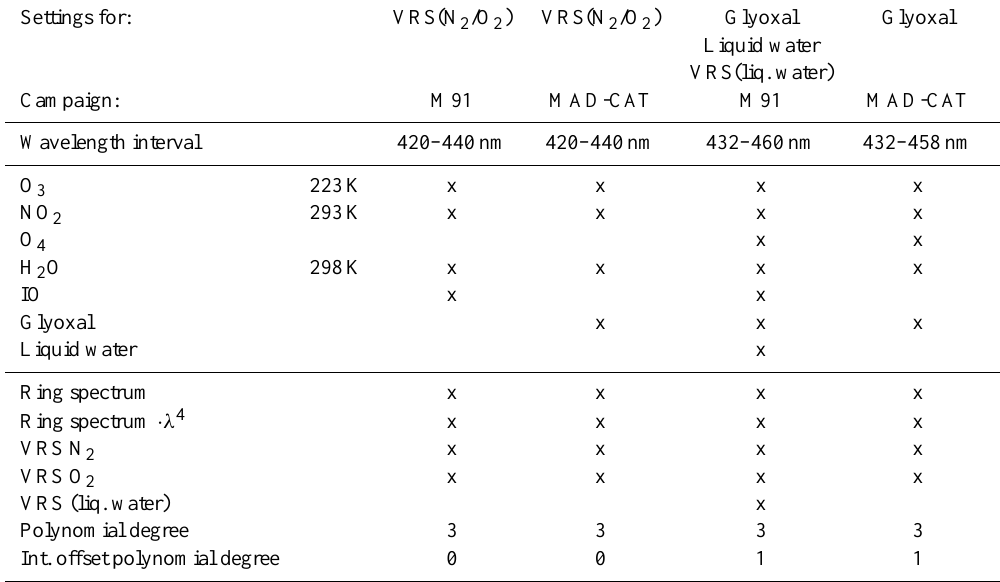
Table 8. Retrieval wavelength intervals for the MAX-DOAS measurements from M91 and MAD-CAT using the literature absorption cross- sections listed in Table